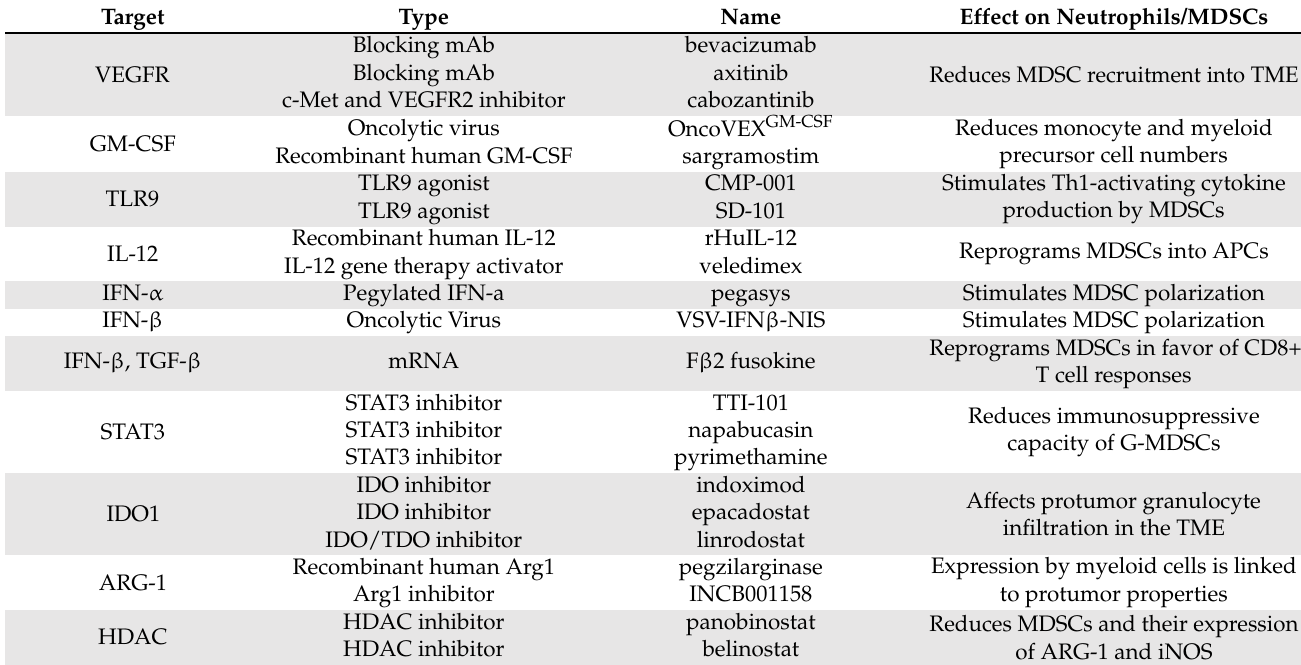
Table 1. Pharmacological compounds targeting TME-derived factors that affect neutrophil function, currently in clinical trials. Data collected on